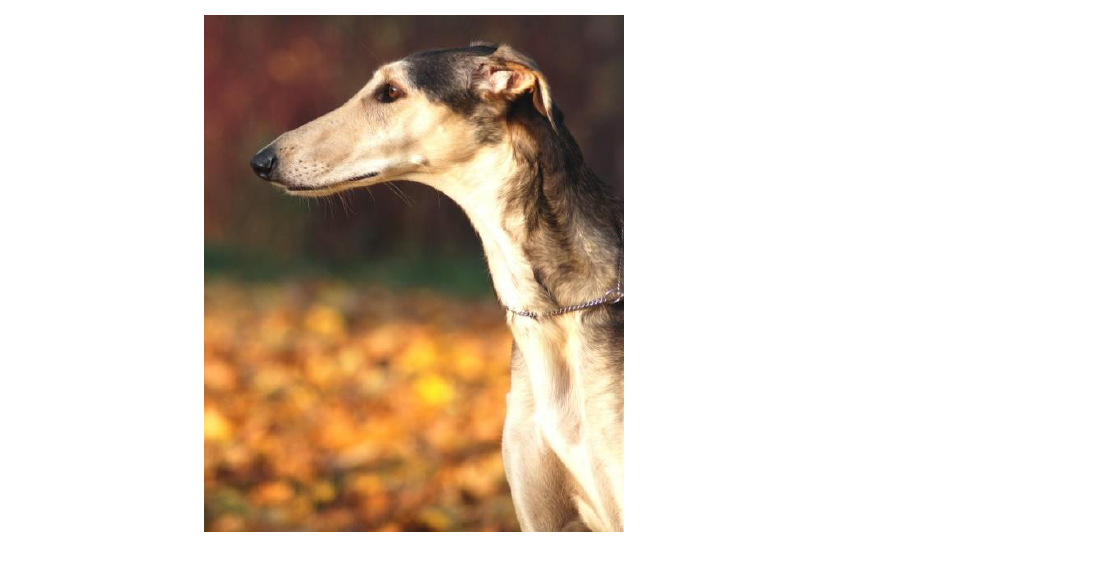
Figure 2. Head of a Polish Greyhound. female: TRZMIELINA Divinacanis, in grizzly color with domino marks—breeder and owner, Marta Kościańska (photo: Marta Kościańska).